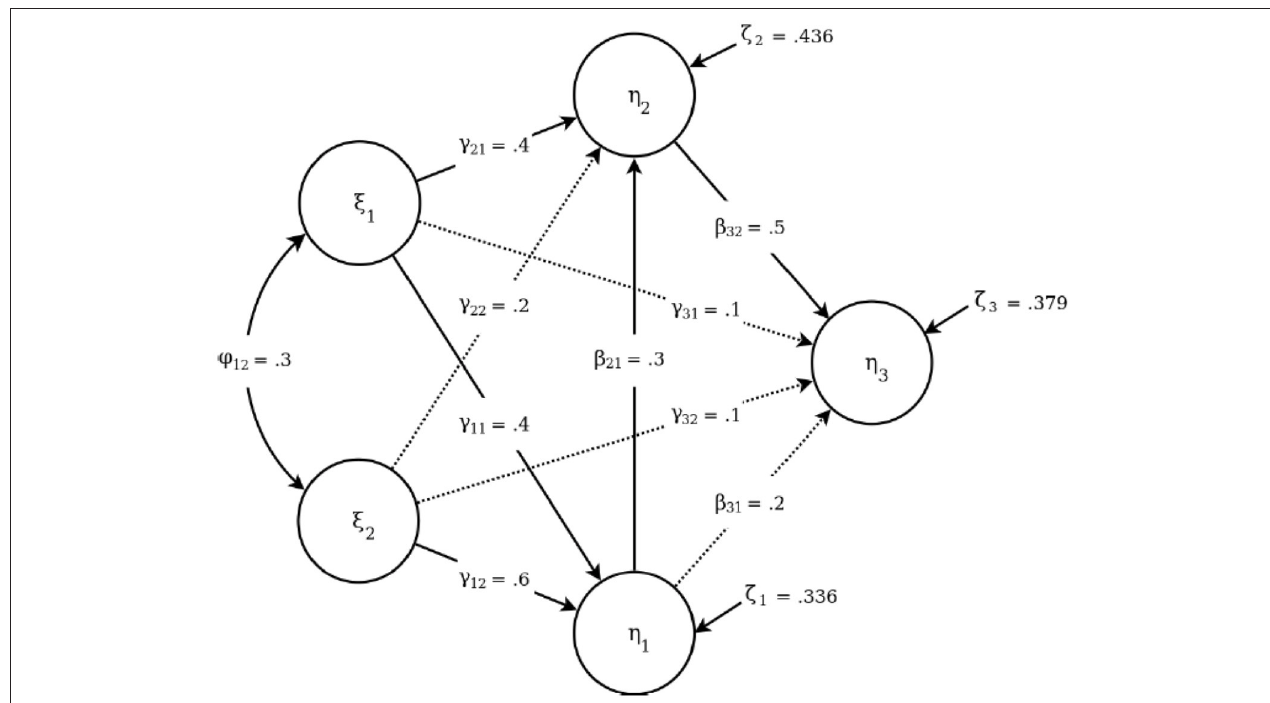
FIGURE 1 | The population structural model with five latent variables. The paths omitted in the misspecification condition are displayed as dotted